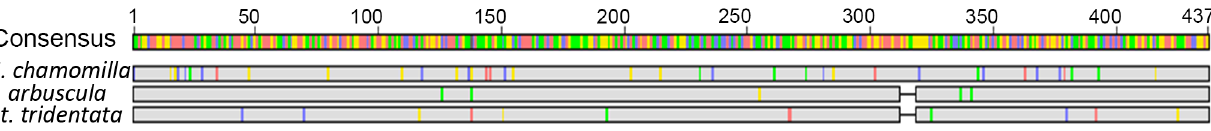
Fig 3. Multiple sequence alignment for a partial transcript of the MrTPS5 gene. A multiple sequence alignment of A . arbuscula , A . tridentata and M . chamomile showing the same 6 SNP base pair deletions present in the genus Artemisia. SNP loci are highlighted as blue for cytosine, green for thymine, yellow for guanidine and red for adenine. Geneious generated the consensus sequence by a majority vote